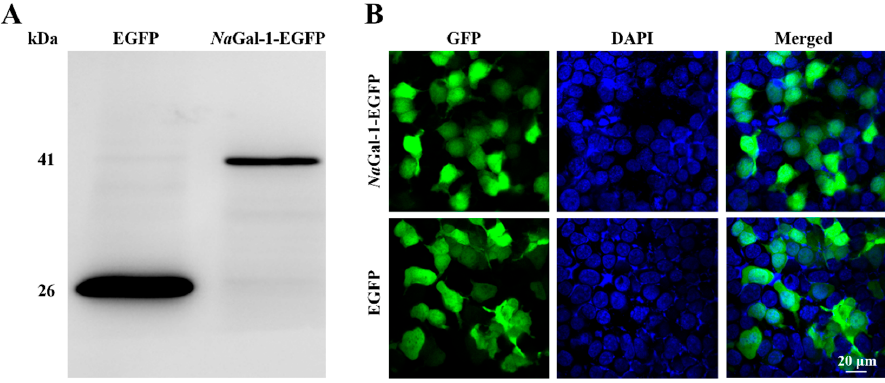
Figure 5. Expression of Na Gal-1 in HEK 293T Cells. ( A ) Western blot of Na Gal-1-EGFP (41.26 kDa) compared with control EGFP (26 kDa), and ( B ) Expression of Na Gal-1-EGFP in HEK 293T cells was found in both cytoplasm and nucleus observed under the confocal fluorescence microscopy.